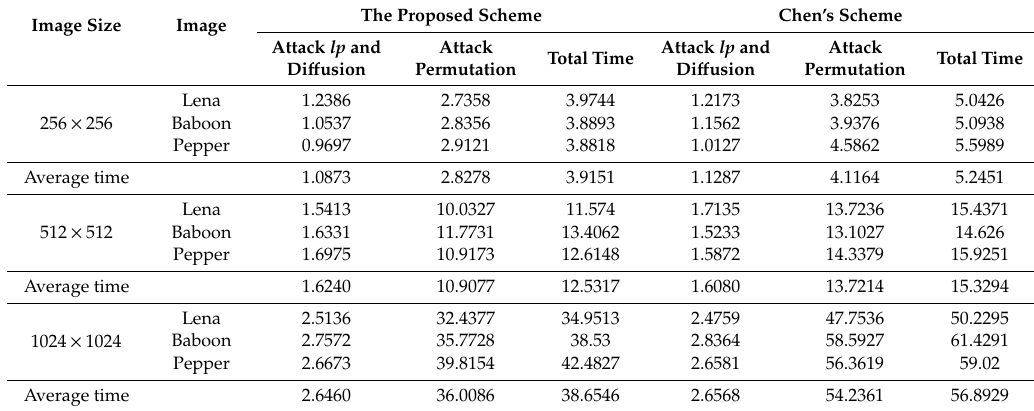
Table 2. Execution time (seconds).